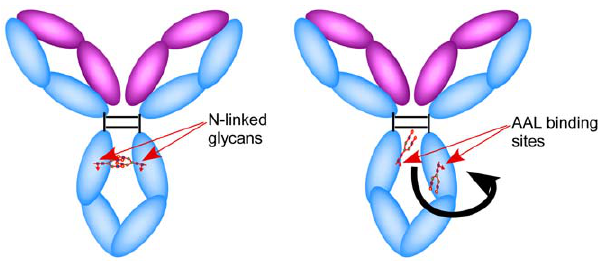
Figure 7. A hypothetical model of non AAL-reactive IgG in ‘‘closed’’ ( left ) and a ‘‘flip-out or open’’ ( right ) conformation. The ‘‘closed’’ conformation may not allow AAL access to the fucose moieties on IgG Fc-glycan, but the ‘‘open’’ conformation might.